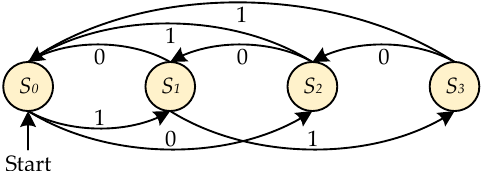
Figure 3. State transition diagram of a basic finite state machine ( FSM).